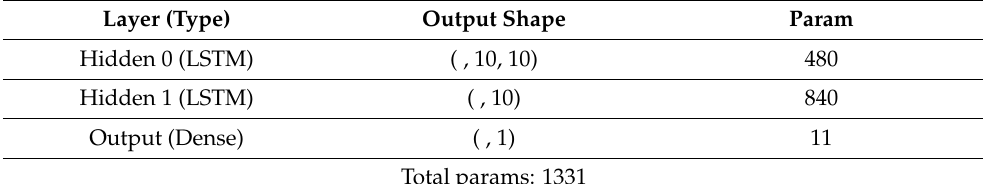
Table 1. Number of nodes in each hidden layer (LSTM).